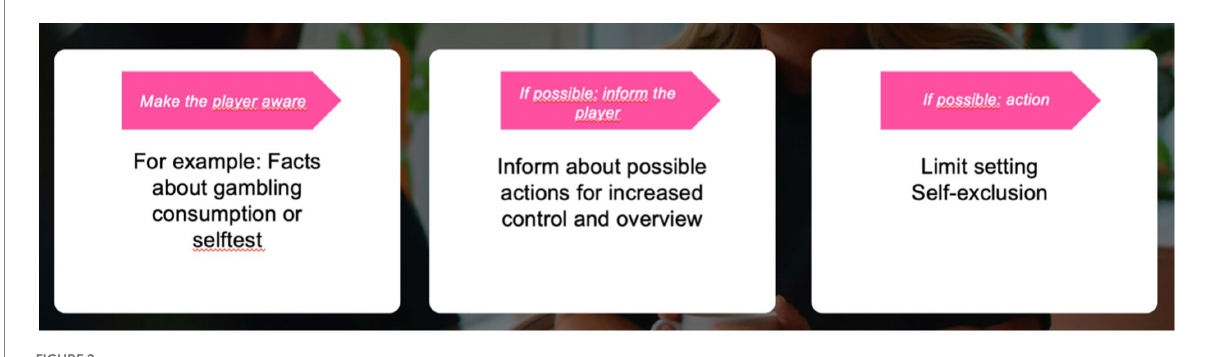
FIGURE 2 Stylistic structure for the planning of motivational intervention calls.